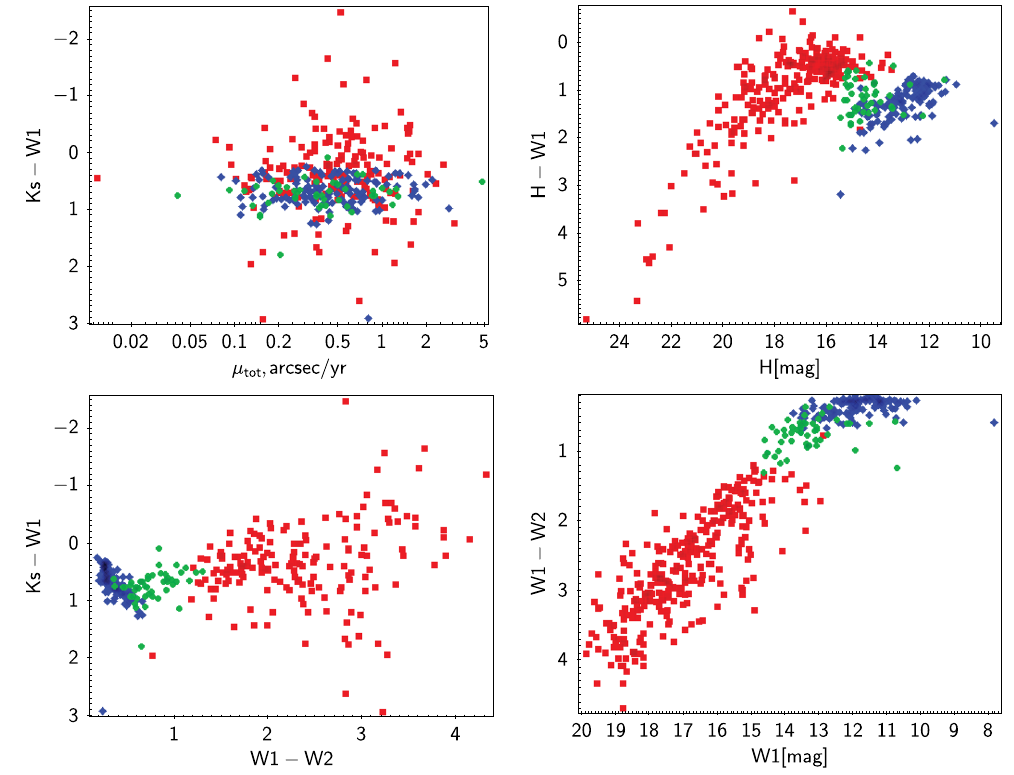
Figure 3: K W − 1 s color index vs proper motion in arcsec per year ( top left ) . H W − 1 – H diagram ( top right ) . K W − 1 s – W W 1 − 2 diagram ( bottom left ) . W W 1 − 2 – W 1 diagram ( bottom right ) . Bright BDs are indicated in blue, transit in green, and faint in